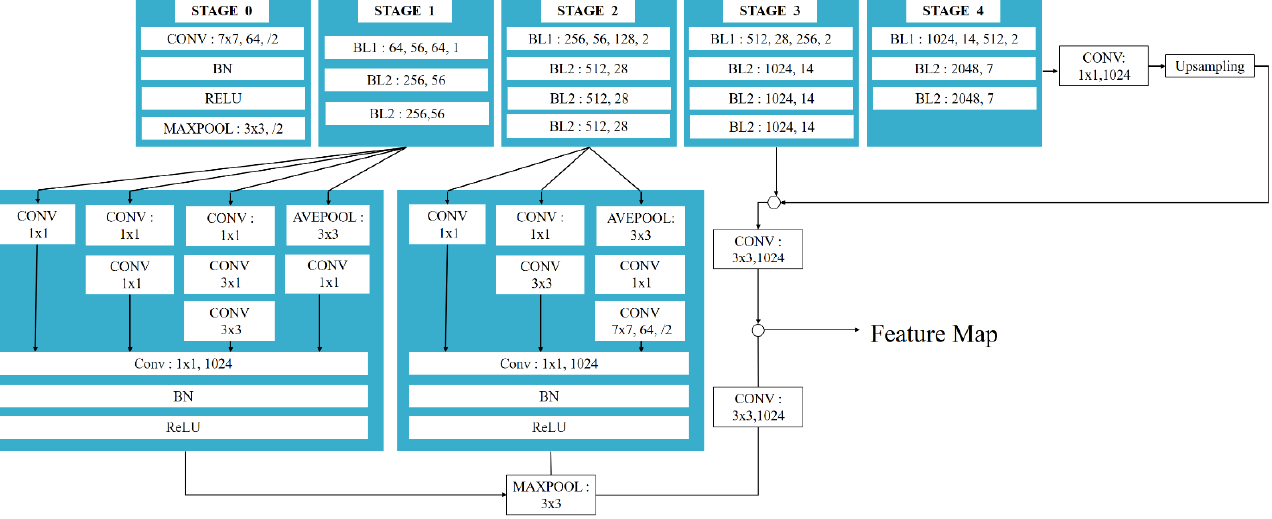
Figure 5. DToolnet feature extraction network structure.